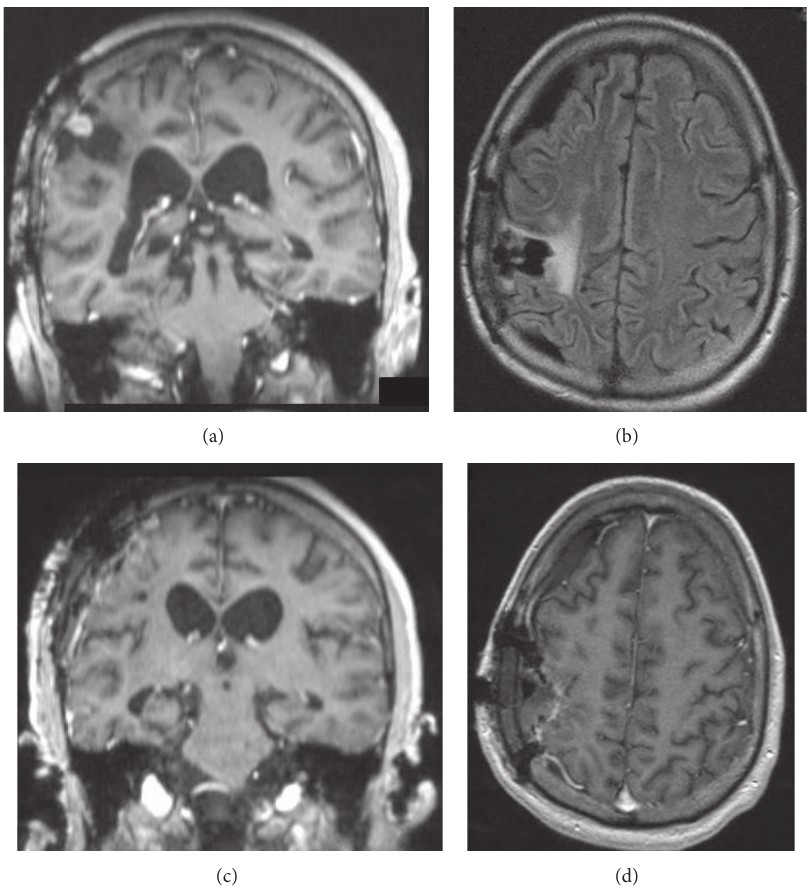
Figure 4: ((a),(b)) Preoperative axial flair MRI and T1 coronal MRI showing a recurrent new 7mm nodular area of enhancement at the superior aspect of the surgical cavity associated with the dura. ((c),(d)) Postoperative axial flair MRI and T1 coronal MRI showing resection of the